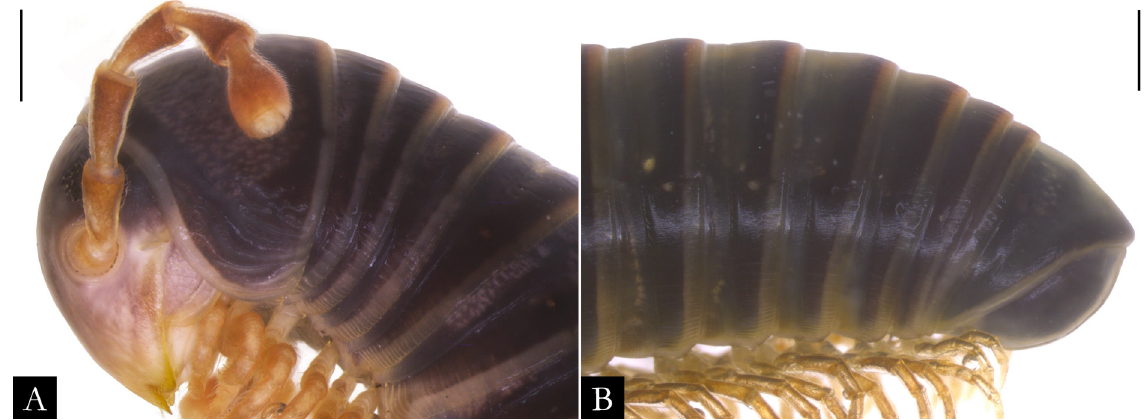
Fig. 145. Pseudonannolene alata sp. nov., holotype, ♂ (IBSP 7874), in lateral view. A . Anterior region. B . Posterior region. Scale bars = 1